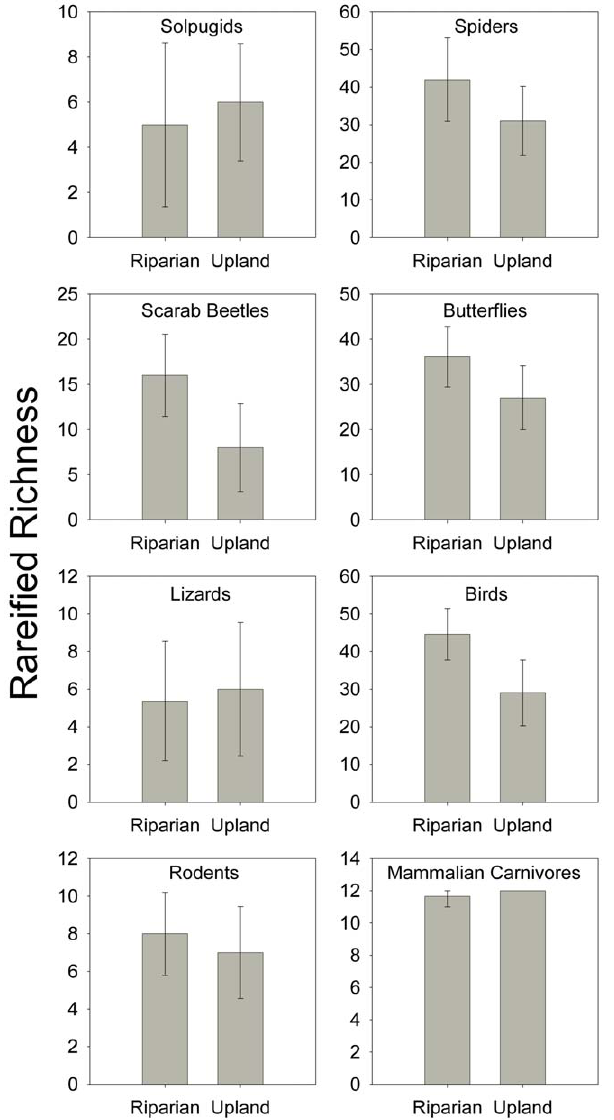
Figure 6. Abundance by zone for each taxonomic group. Bootstrapped abundance estimates ( 6 95% confidence intervals) for the eight taxa sampled in both riparian and upland zones along the upper San Pedro